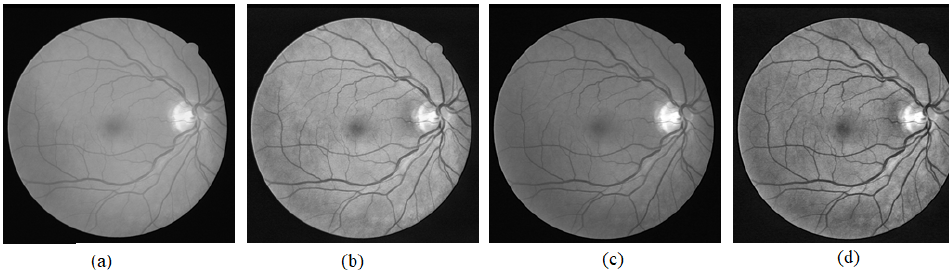
Figure 13. Green channel extraction and CLAHE on Photo 1 . ( a ) Grayscale image. ( b ) CLAHE on grayscale image. ( c ) Extracted green channel. ( d ) CLAHE on extracted green channel.